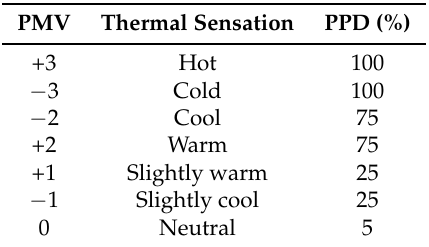
Table 1. The relationship between predicted mean vote (PMV), predicted percentage of dissatisfied (PPD), and thermal sensation.